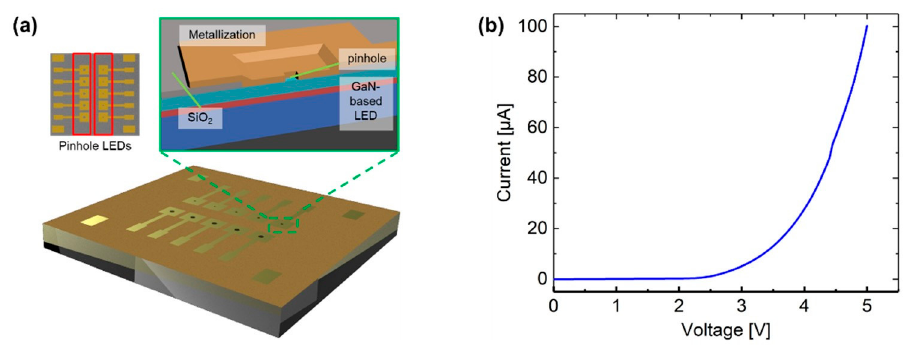
Figure 2. ( a ) Principle sketch of the pinhole LED arrays. ( b ) Measured I ‐ V curve of a single pinhole LED having a diameter of 90 μ m.